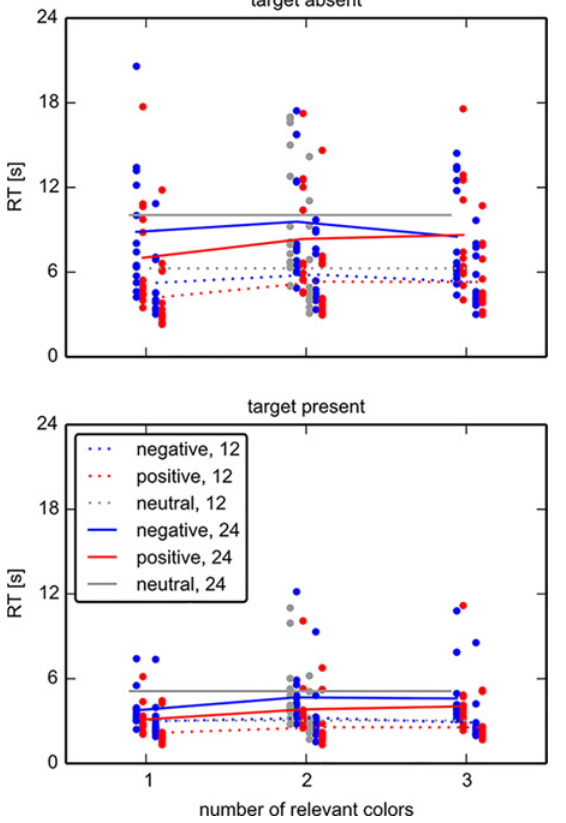
Fig 7. Response times in experiment 2. The response times for target absent trials (top) and target present trials (bottom) are shown, split by cue type and array size. The main determinant of response time is array size, but cue type also plays a consistent role with positive cues eliciting the fastest responses, and neutral cues the slowest